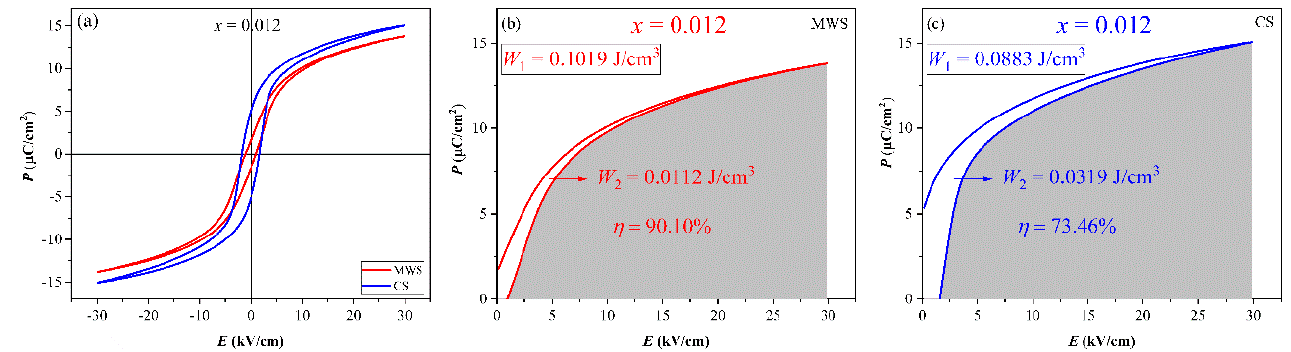
Figure 7. ( a ) P-E loops, energy storage performance of ( b ) MWS and ( c ) CS of BTS-BCT- x BF ceramics with x = 0.012.